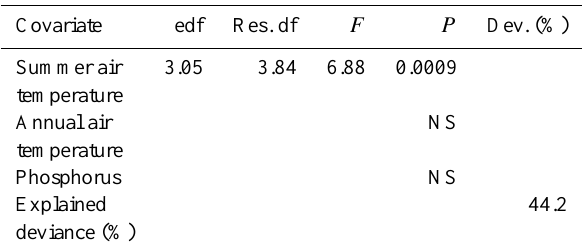
Table 2. Model summary for the additive mixed model fitted to the Synechococcus relative abundance (% of total cyanobacteria as re- vealed by qPCR counts). Covariate edf Res. df Dev.